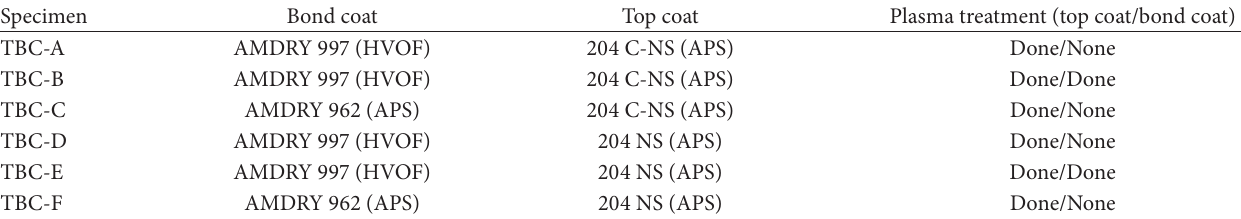
Table 2: TBC specimens used in this study for evaluating thermal